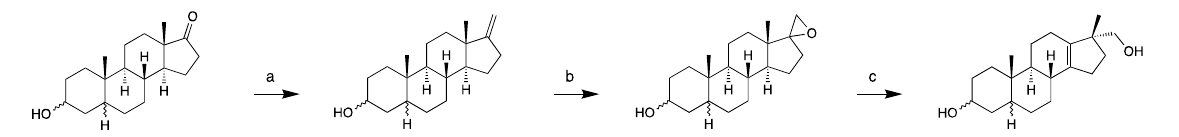
Figure 4. Reaction scheme for 17 α -hydroxymethyl-17 β -methyl-18-nor-5 ξ -androst-13-en-3 ξ -ol steroids. As is common in diastereomers, all yielded very similar mass spectra. As an exam- ple, the spectrum of 17 α -hydroxymethyl-17 β -methyl-18-nor-5 β -androst-13-en-3 α -ol ( 8 ) is displayed in Figure 5. Using electron ionization at low energy (15 eV, low energy electron ionization, LEI) the molecular ion, which was literally invisible at regular ionization energy (viz. 70 eV), was detected at the accurate mass m / z 448.3162. The retention time of the bis-trimethylsilyl (TMS) derivatives of the diastereomers are given in Table 1. Further struc- ture confirmation was achieved by 1D and 2D-NMR analysis. Assignments are provided in Table 2.